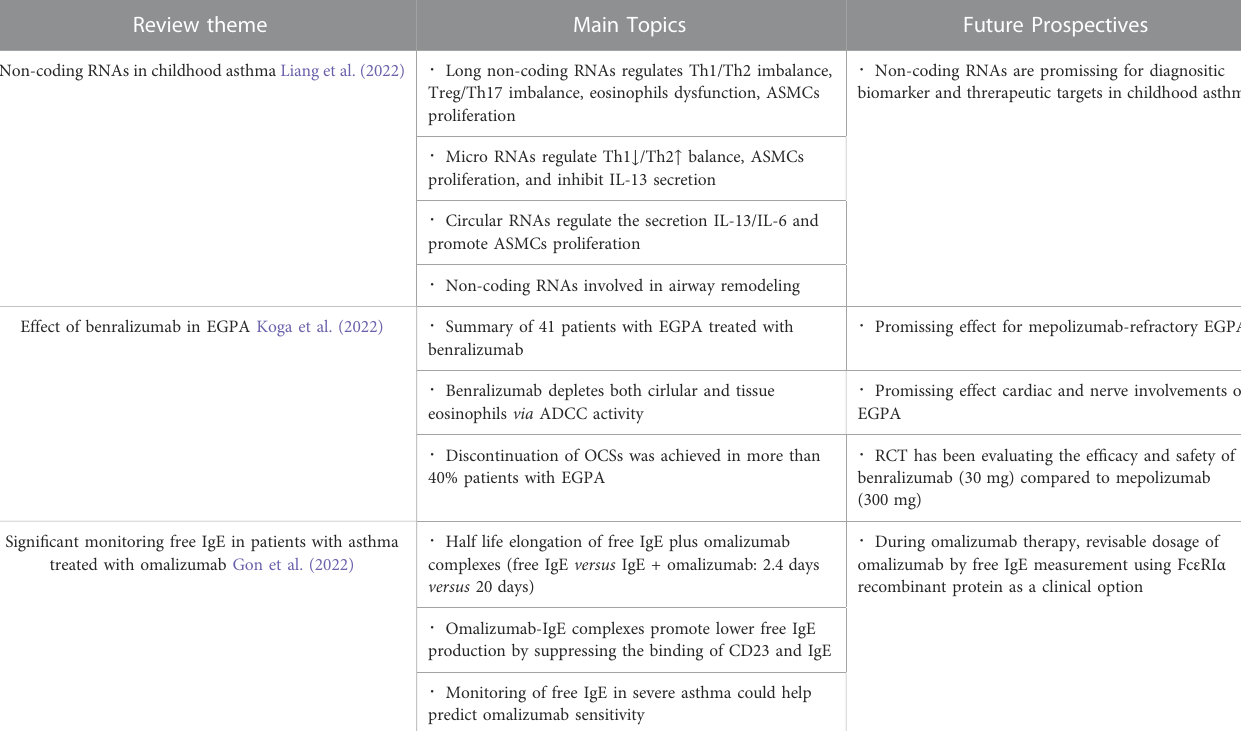
TABLE 1 Summary of